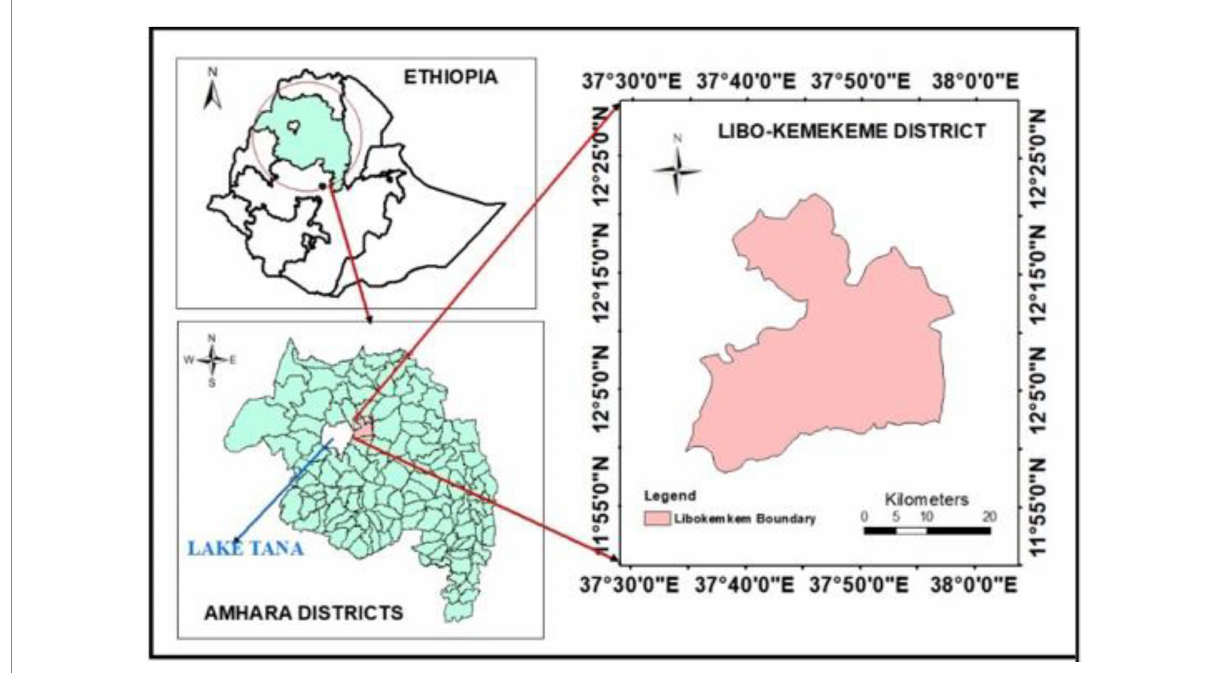
FIGURE 1 Location of Libo-kemkem district, North-Western